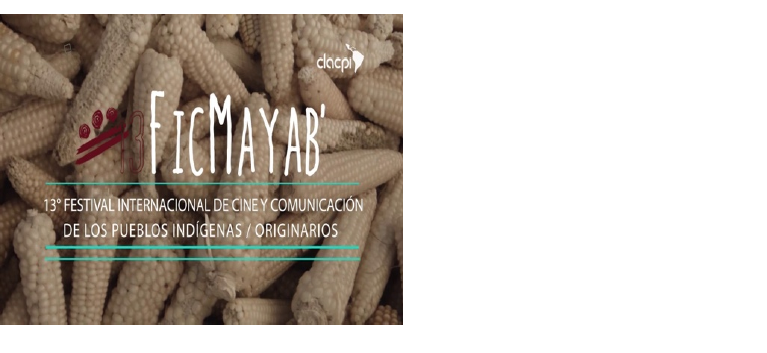
Figure 2. Indigenous Native Peoples International Festival of Cinematography and Communication. Source: www.clacpi.org, accessed on 11 September 2021.